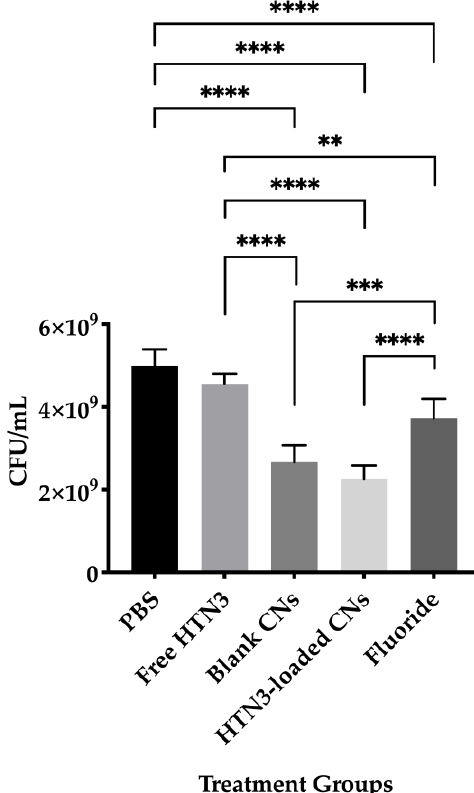
Figure 7. Bacterial viability for the four treatment groups were compared against the control group treated with PBS only. While free HTN3 did not control bacterial growth, fluoride treatment significantly decreased bacterial growth. Blank and HTN3-loaded CNs were the most effective at decreasing bacterial population but are insignificantly different from each other (** p ≤ 0.01, *** p ≤ 0.001, **** p ≤ 0.0001).